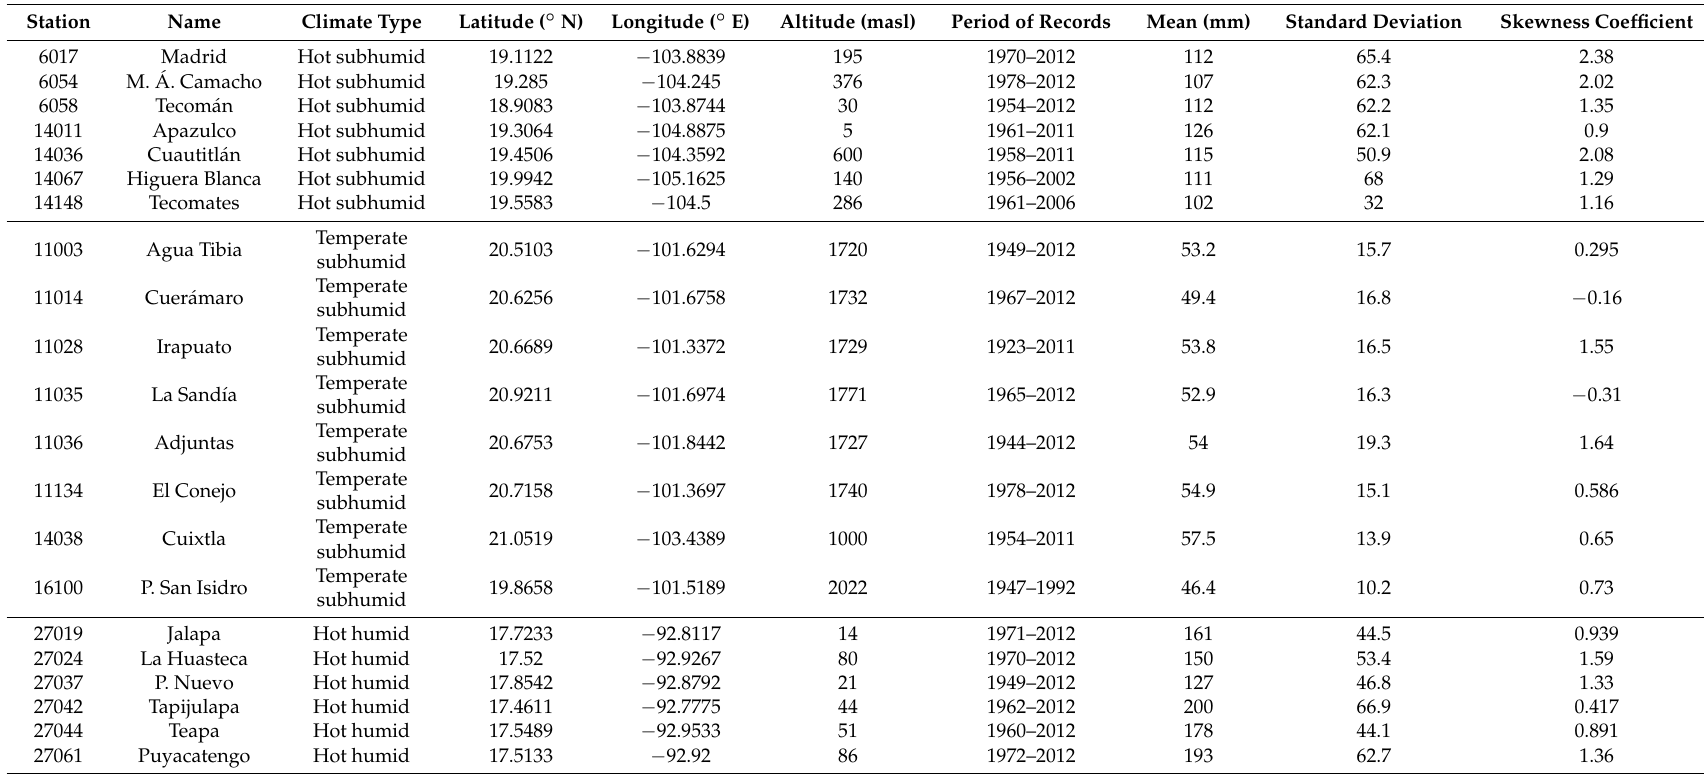
Table 1. Geographic location and information from the meteorological stations used in the